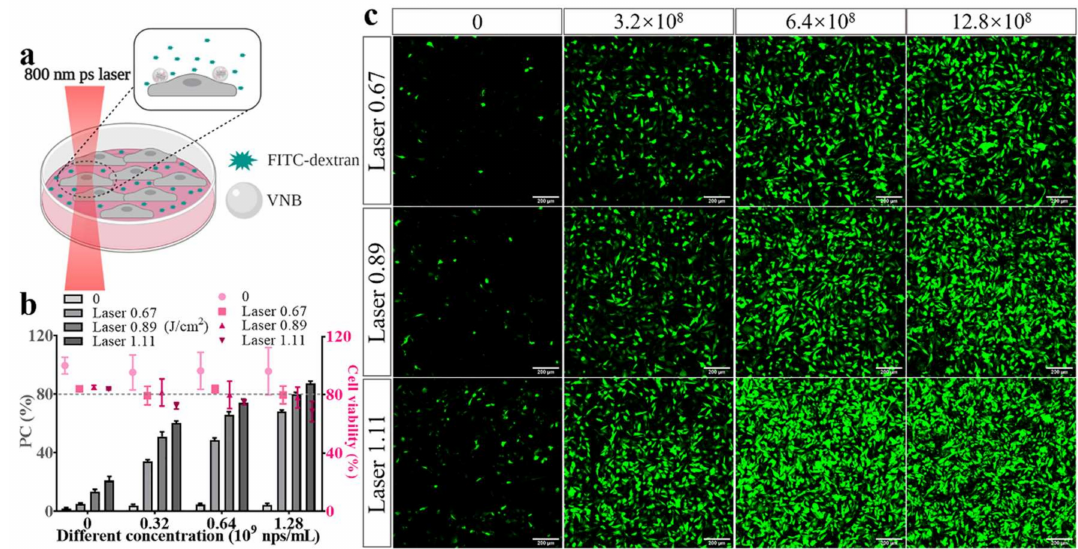
Figure 6. Intracellular delivery of FD10 by NIR laser-induced photoporation with rGO-PEI. ( a ) Conceptual illustration of the photoporation experiment. Created with Biorender.com. ( b ) Quantification of the percentage of FD10 positive cells by flow cytometry. Cell viability was determined by CellTiter-Glo ® 2 h after photoporation treatment. ( c ) Confocal microscopy images of HeLa cells labeled with FD10 with increasing particle concentrations (columns) and increasing laser fluence (rows). The scale bar is 200 µ